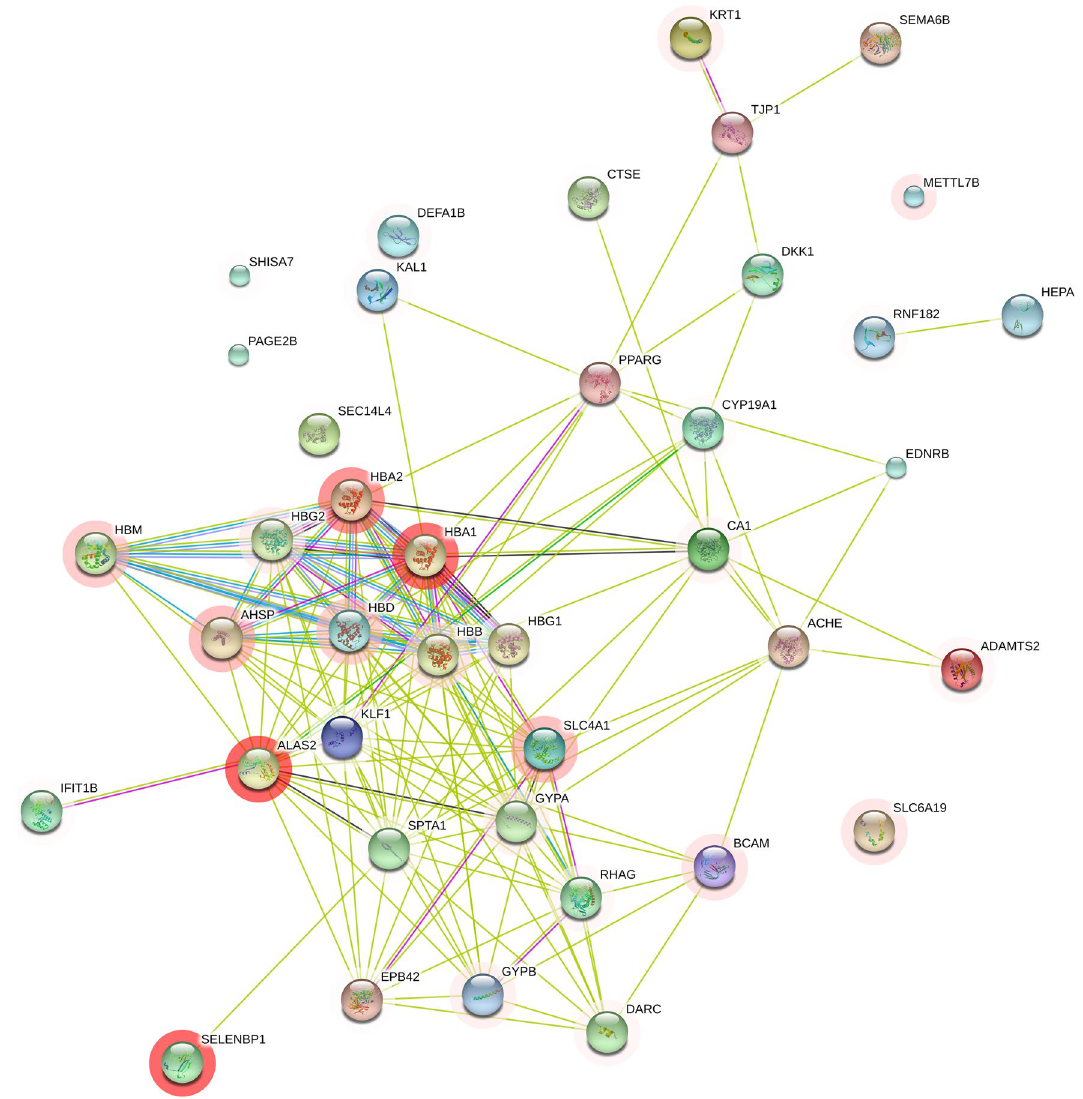
Figure 7. PPI network of DEGs in HCC. It was created using iDEP version 0.92, http:// bioin forma tics. sdsta te. edu/ idep/. The ball surrounded by shadows denoted upregulated genes and others showed downregulated